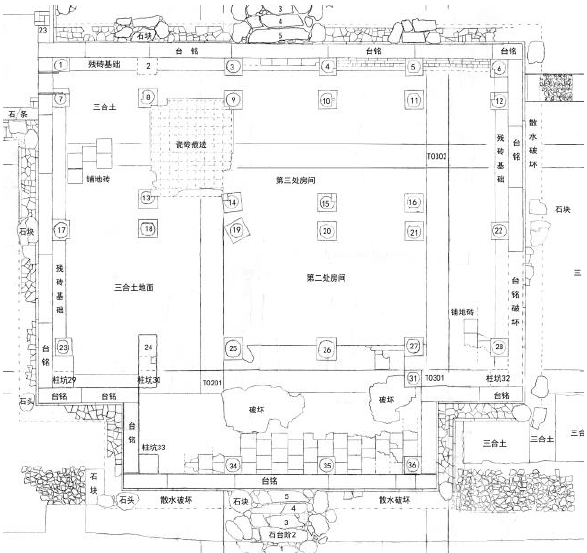
Figure 2. Archaeological site plan of Ruyuan Garden, the Summer Palace, Beijing